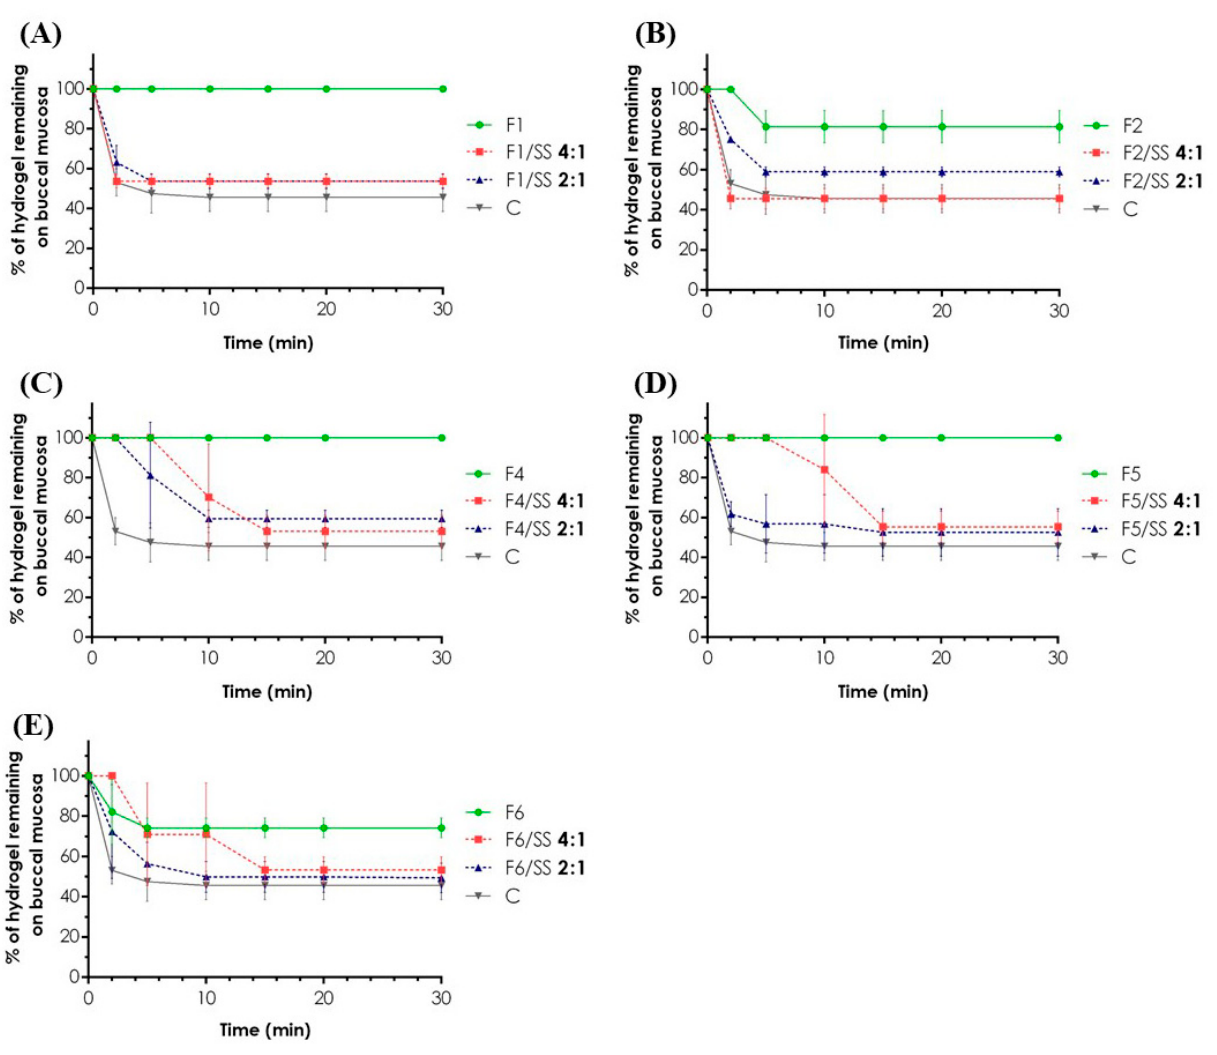
Figure 4. In vitro mucoadhesive properties of the carriers determined as% of a hydrogel/diluted hydrogel F1 ( A ), F2 ( B ), F4 ( C ), F5 ( D ), and F6 ( E ) remaining on the porcine buccal mucosa over 30 min of an experiment at 37 °C ± 2 °C. Commercially available product (C—control) was used in its undiluted form as a reference (mean ± SD, n = 3).